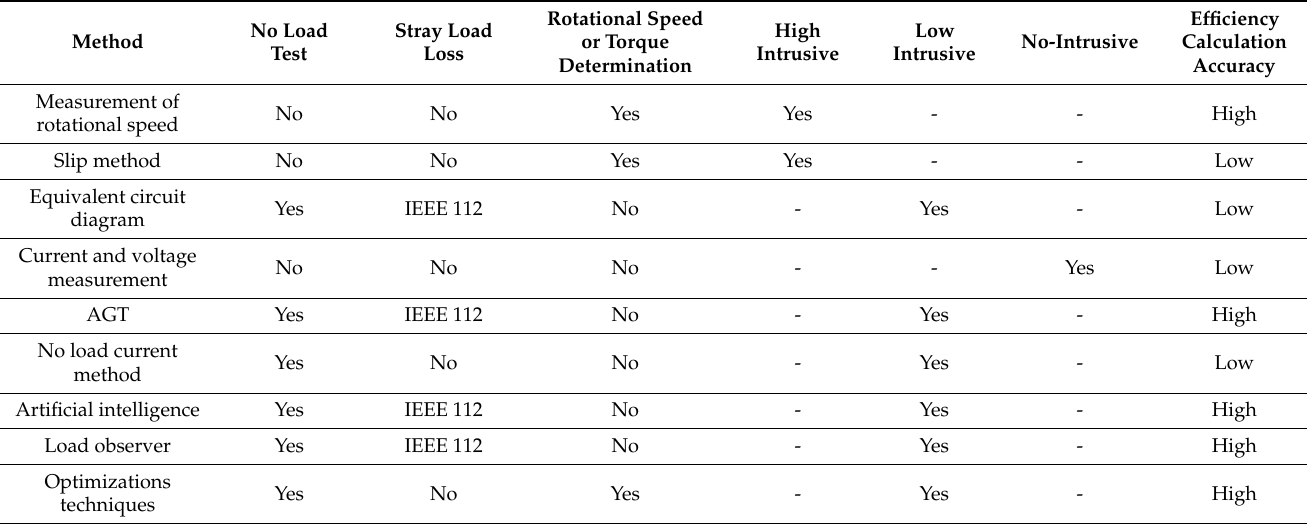
Table 1. Comparison of methods of motor efficiency